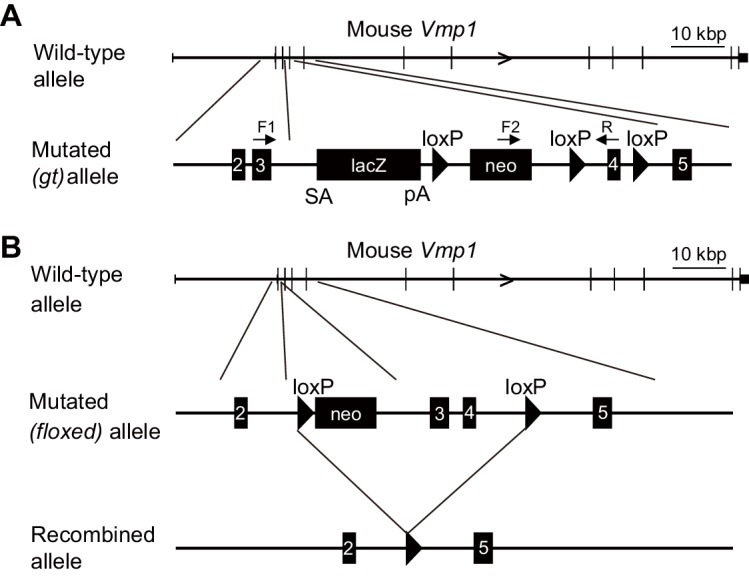
Genetic map of the gene-trap and floxed alleles of the mouse Vmp1 gene in Vmp1gt mice and Vmp1flox mice, respectively.(A) Genomic map of the wild-type and gene-trap (gt) alleles of the mouse Vmp1 gene. Black boxes indicate exons 2 to 5 and the lacZ and neo cassettes. Three loxP sites (triangles) and three primers (F1, F2, and R) used for genotyping are shown. SA, splice acceptor site. pA, poly A signal. (B) Genomic map of the wild-type, floxed, and recombined alleles of the mouse Vmp1 gene. Black boxes indicate exons 2 to 5 and neo cassettes. Triangles indicate loxP sites.